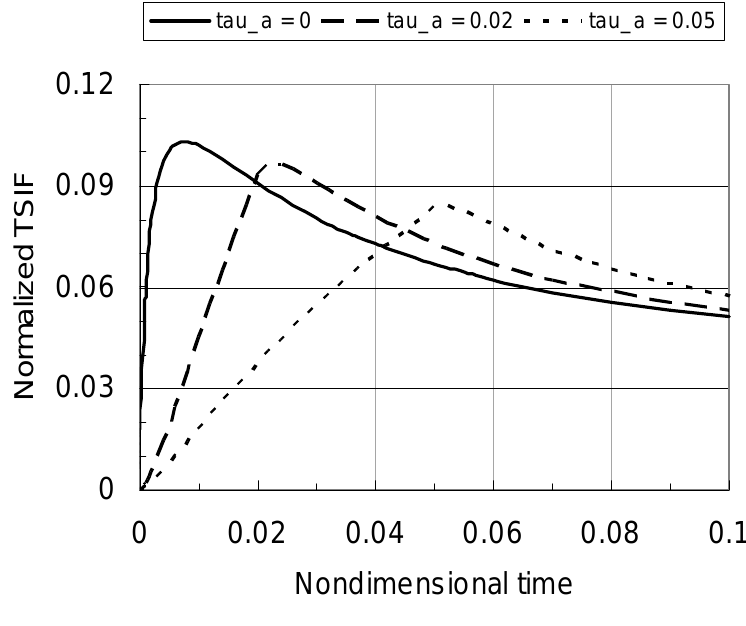
Figure 4. Normalized TSIF versus nondimensional time for a TiC/SiC FGM ( a / b = 0.1, p =